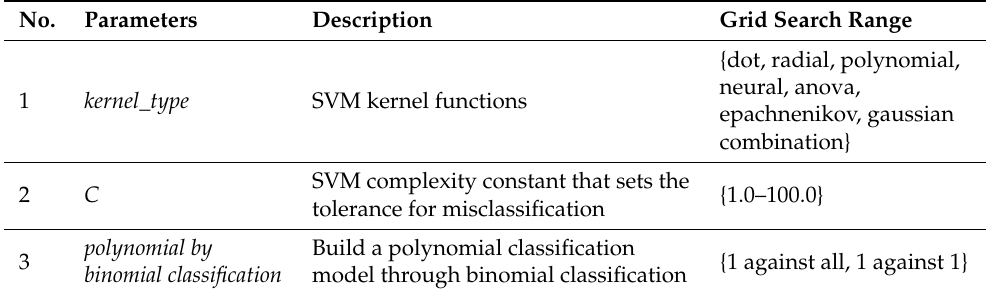
Table 6. SVM model parameter settings.